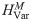
Relation between amplitude of perceptual boundary shift and amount of compensation for hypothesis HVarM and hypothesis HVarΦ.Top panels: considered amplitude of update in the auditory-motor internal model (left) and the amplitude of shift in the auditory characterization of the perturbed phoneme (right). Middle panels: relation between degree of compensation and amount of perceptual shift for each adaptation hypothesis in the case of a local update of the internal model. Colors correspond to the different magnitudes of internal model updates, as indicated in the top left panel. Darkness indicates the amplitude of shift of the auditory characterization of the perturbed phoneme, as indicated in the top right panel. Bottom panel: corresponding amplitude of correlations.